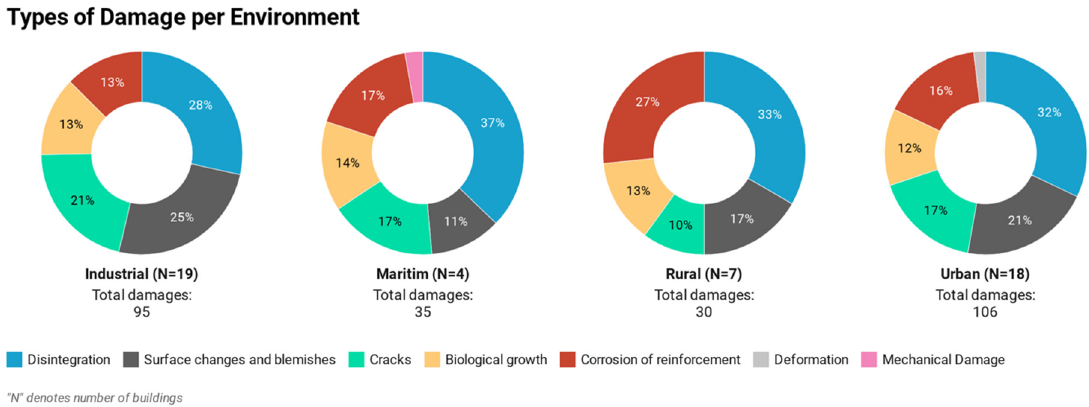
Figure 6. Types of damage per environment.